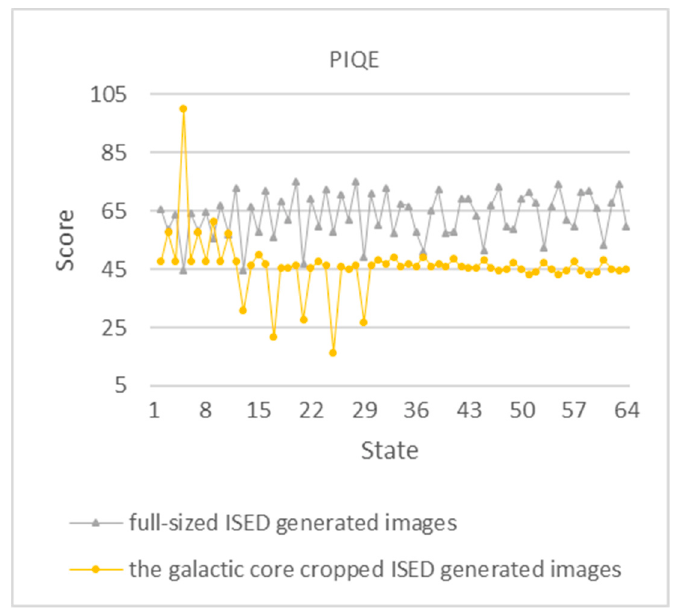
Figure 15. PIQE values of 63 ISED-generated images. The cropped images of M87 shown in Figure 9.